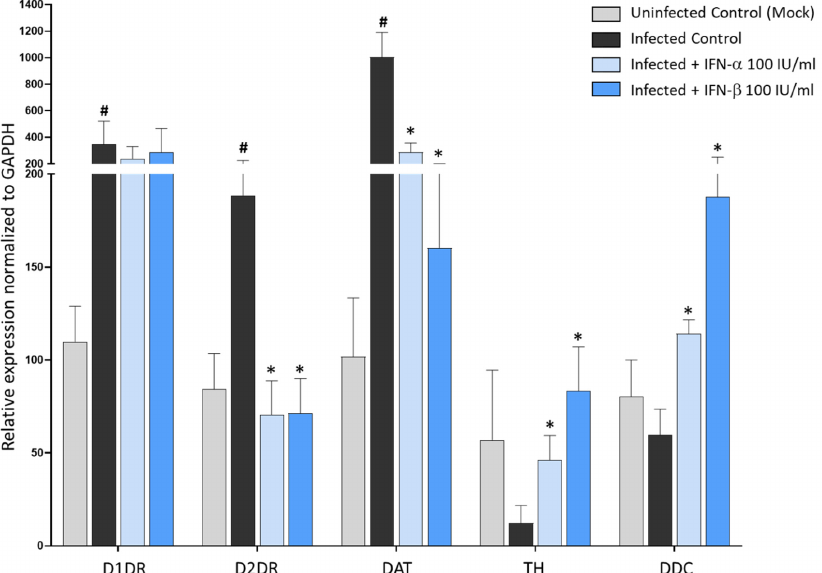
Figure 8. Type-I Interferons reverse SARS-CoV-2 induced changes in the expression of DA-related genes. Compared with Uninfected Control (Mock), SARS-CoV-2 (Infected Control) at 48 h post- infection potentiates the expression of D1DR, D2DR, and DAT meanwhile downregulating TH and DDC. Treatment of SARS-CoV-2-Infected cells with Type-I Interferons (IFN- α , - β , 100 IU/mL) reduces D2DR and DAT expression while potentiating TH and DDC expression in CaLu-3 cells. mRNA quantification was performed through real-time qPCR and calculated by the 2 −ΔΔ Ct equation. Results are presented as mean ± SEM from at least n = 3 independent experiments, each performed in triplicate. # p < 0.05 vs. Uninfected Control (Mock), * p < 0.05 vs. SARS-CoV-2-Infected Control (SARS-CoV-2).